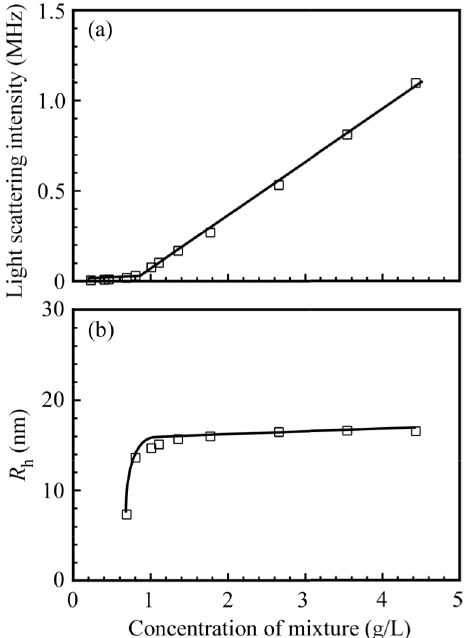
Figure 6. ( a ) Light scattering intensity and ( b ) hydrodynamic radius ( R h ) of the PNaSS 58 – b– PAA 125 /PNaSS 58 – b –PNIPAM 115 complex as a function of the concentration of the mixture in 0.1 M NaCl at pH 3.